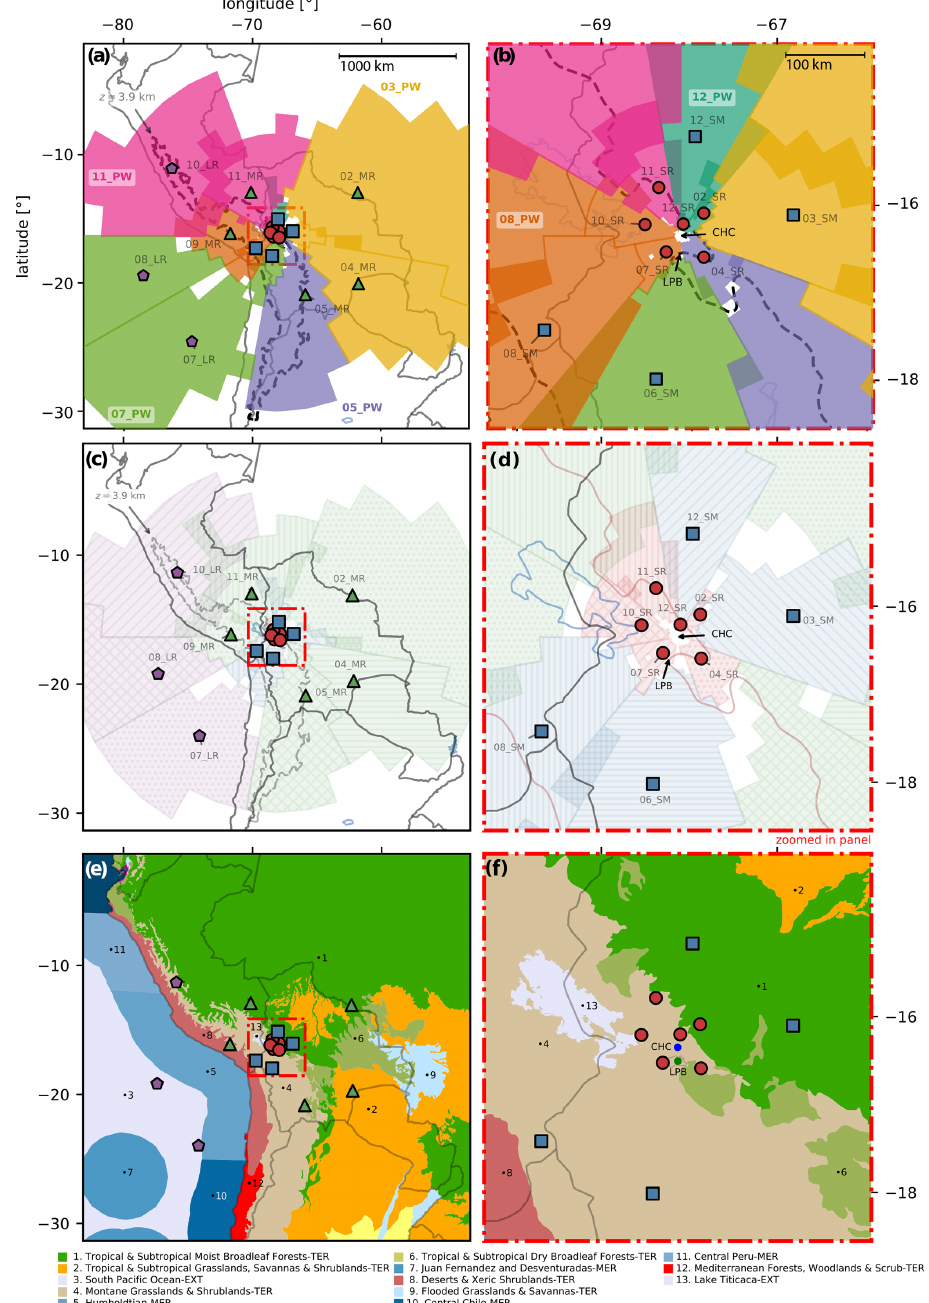
Figure 6. The shading in (a) and (b) shows the horizontal extent of the six main PWs. For easier visualization we only shade grid cells which have SRR values in the top 80% for each cluster. Each cluster centroid is marked with a disk (short range), square (short-medium range), triangle (medium range) or pentagon (long range) locator. The colour of each region is related to the main pathway they belong to (03_PW: yellow; 05_PW: purple; 07_PW: green; 08_PW: orange; 11_PW: pink; and 12_PW: teal). The dashed black line corresponds to a height of 3.9kma.s.l. and encircles the Altiplano plateau. Panel (b) corresponds to the region inside the red rectangle in (a) . Panels (c) and (d) show the horizontal location of the 18 clusters. The colour is related to their distance range from CHC, and the hatch distinguishes each cluster independently. Panel (d) corresponds to the region inside the red rectangle in (c) . The colours, both for the centroid markers and the shaded areas, differentiate the distance range from CHC (SR – short range, SM – short-medium range, MR – medium range and LR – long range). The hatch patterns distinguish the area of each of the 18 clusters. Panels (e) and (f) show the biomes as described in Sect. 4 and are shown to compare the area of the clusters and pathways to the underlying biome. The resulting area overlaps between each cluster and biome are shown in Fig. 9. Figure S3 is similar but shows the ecoregions rather than the